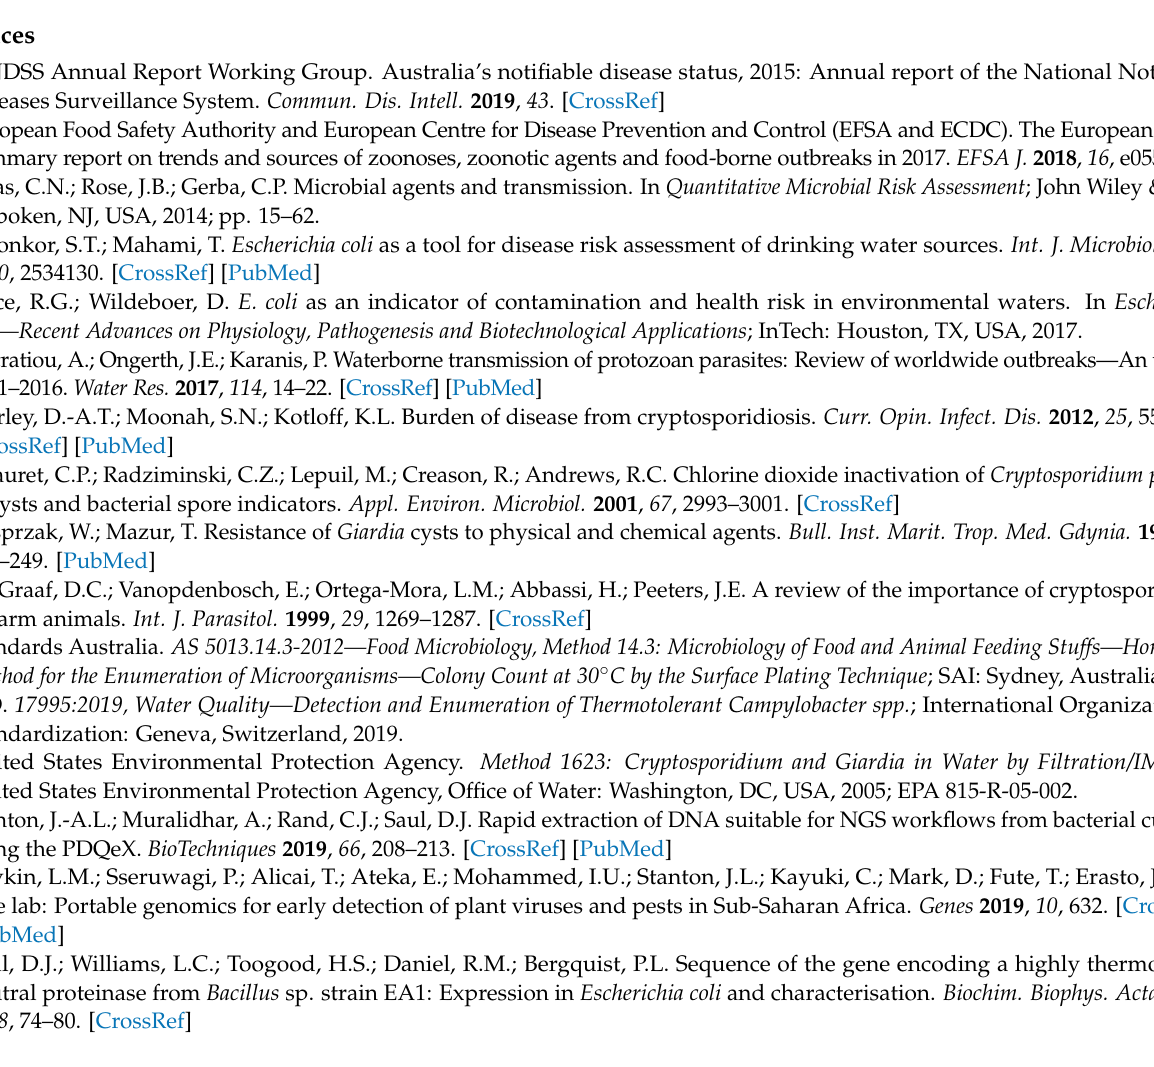
experiment, Table S4: Sensitivity of qPCR against the four pathogens, Table S5: Results of water analysis—inorganics and results of water analysis—chlorine, fluoride and CaCO3, Table S6: Overall quantification or recovery efficiency of molecular-based pathogen quantification